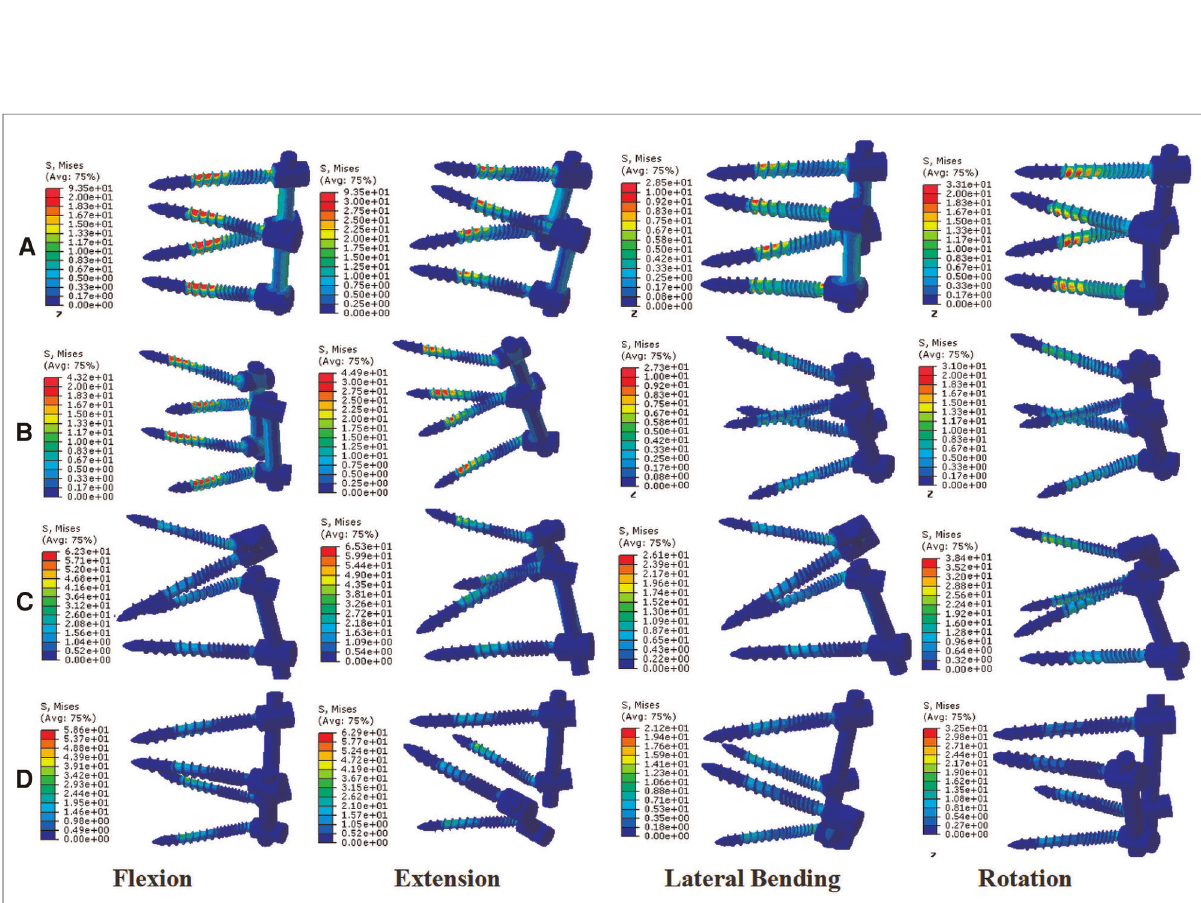
FIGURE 6 Stress nephograms over the posterior fi xations of four different fi xation models: ( A ) the TT-TT group, ( B ) the MCBT-MCBT group, ( C ) the MCBT-TT group, and ( D ) the TT-MCBT